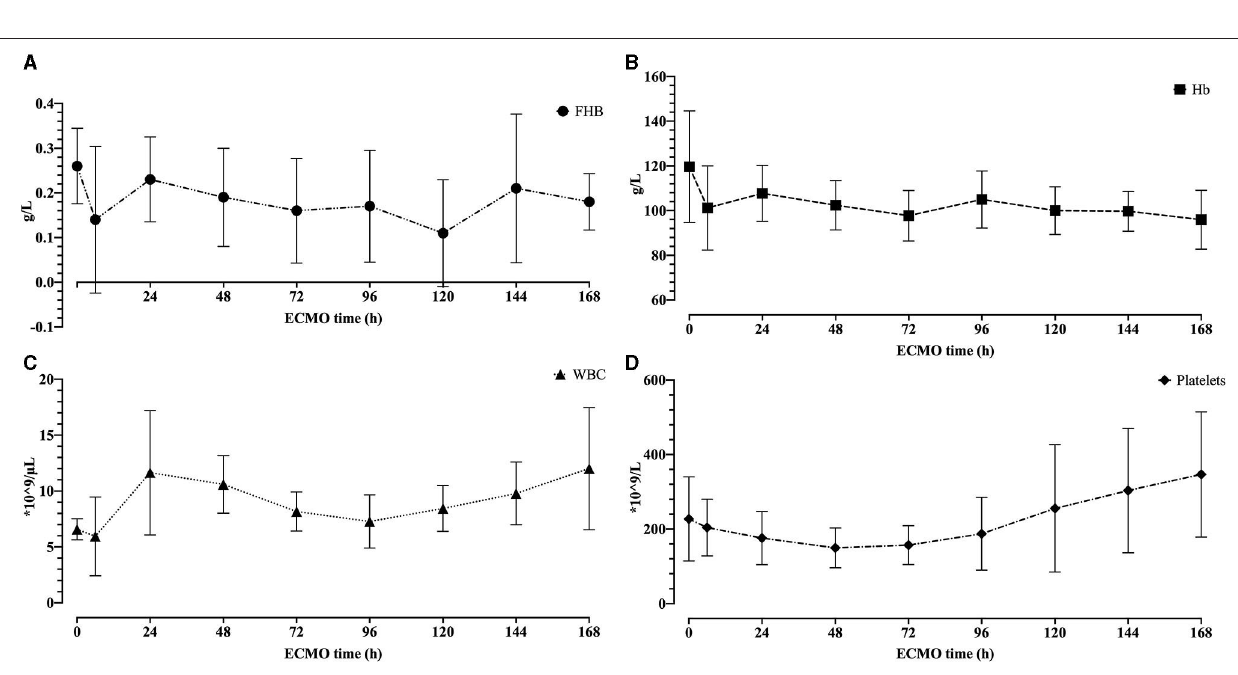
7/10 pumps developed small thrombus in the bearing